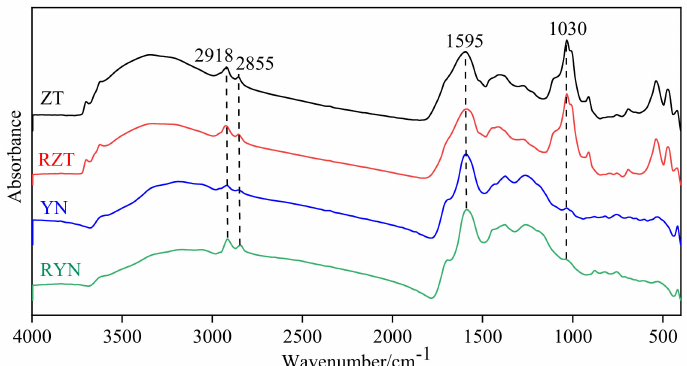
Figure 5. FTIR spectra of coal samples.